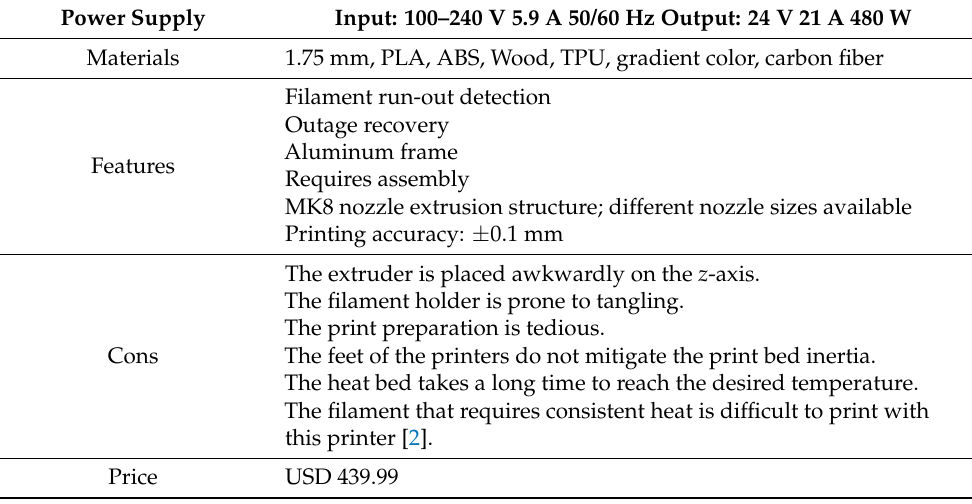
Table 2. Descriptions of Creality 3D Cr-10 Desktop 3D Printer. Power Supply